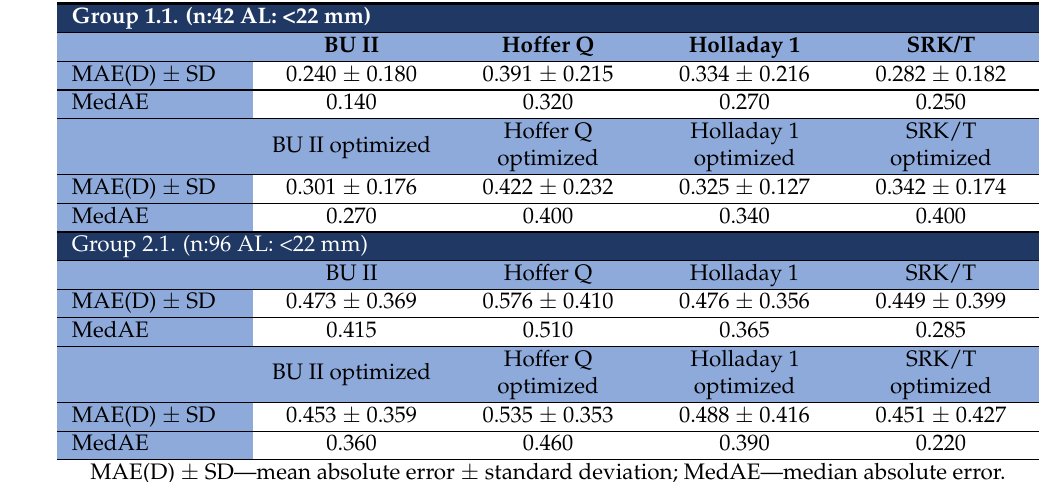
Table 7. Prediction errors for groups with AL < 22 mm.